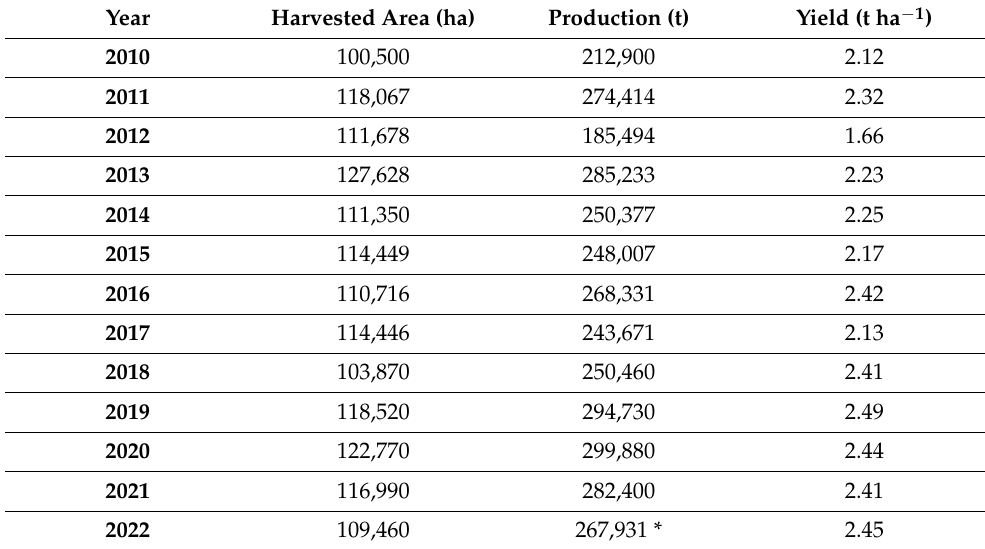
Table 1. Sunflower annual production, harvested areas, and yields in Italy, 2010–2022. (Sources: FAOSTAT and